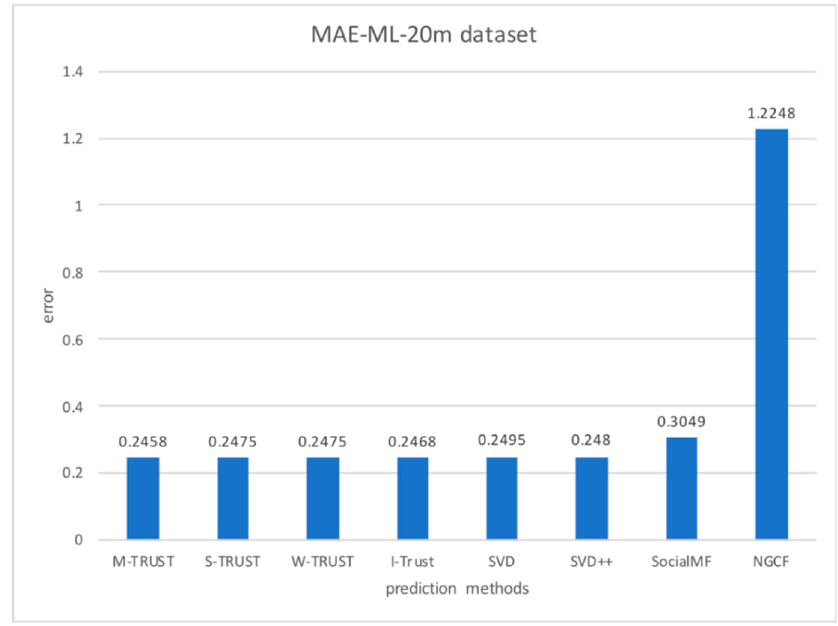
Figure 6. Prediction accuracy for ML-20m data set, as obtained using different methods.